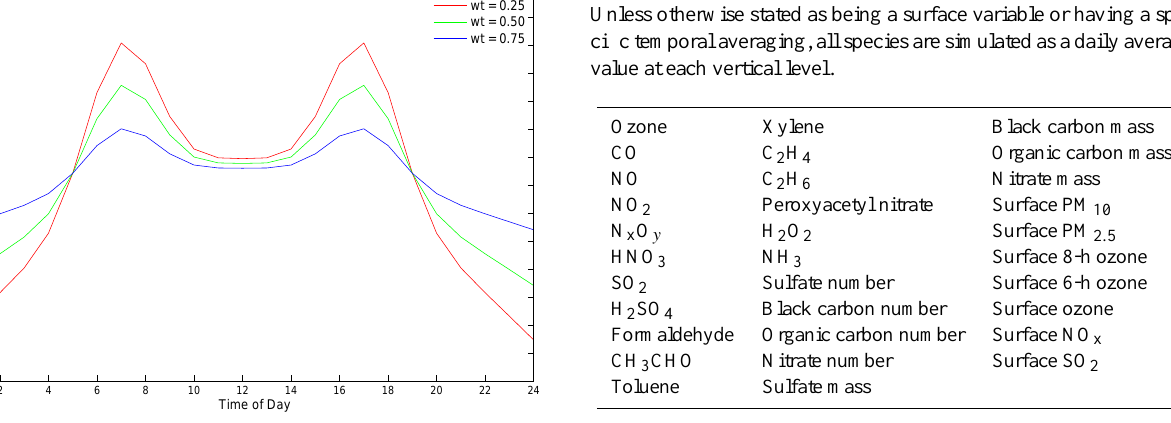
Fig. 4: Example of how the geospatial weighting of emissions impacts the distribution of urban emissions, for two example cases. Frame (a) corresponds to a gaussian standard diameter of 40km and frame (b) to a gaussian standard diameter of 80km. The color scale is identical for both plots.